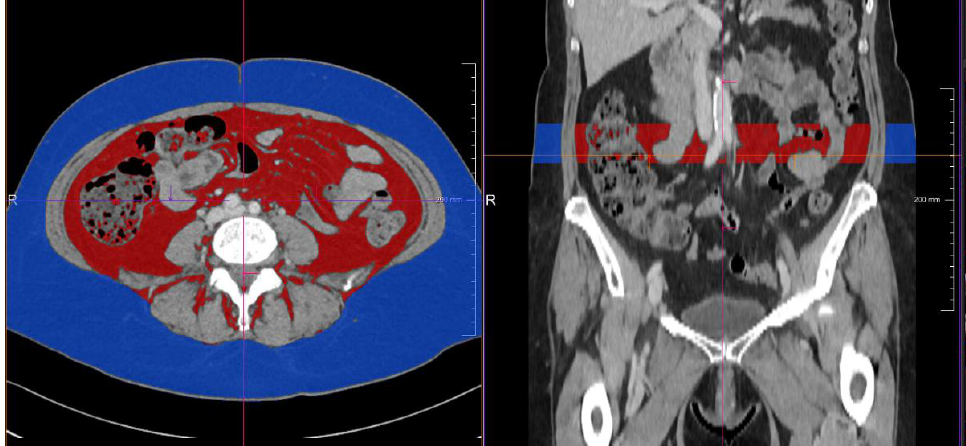
Figure 2. Depiction of computer-tomography (CT)-derived densiometric quantifications of subcutaneous (blue) and visceral (red) fat area performed on image slices between vertebral body L3 and L4. Quantifications were given as volume (mL) and included into statistical analysis in direct comparison to the BMI.